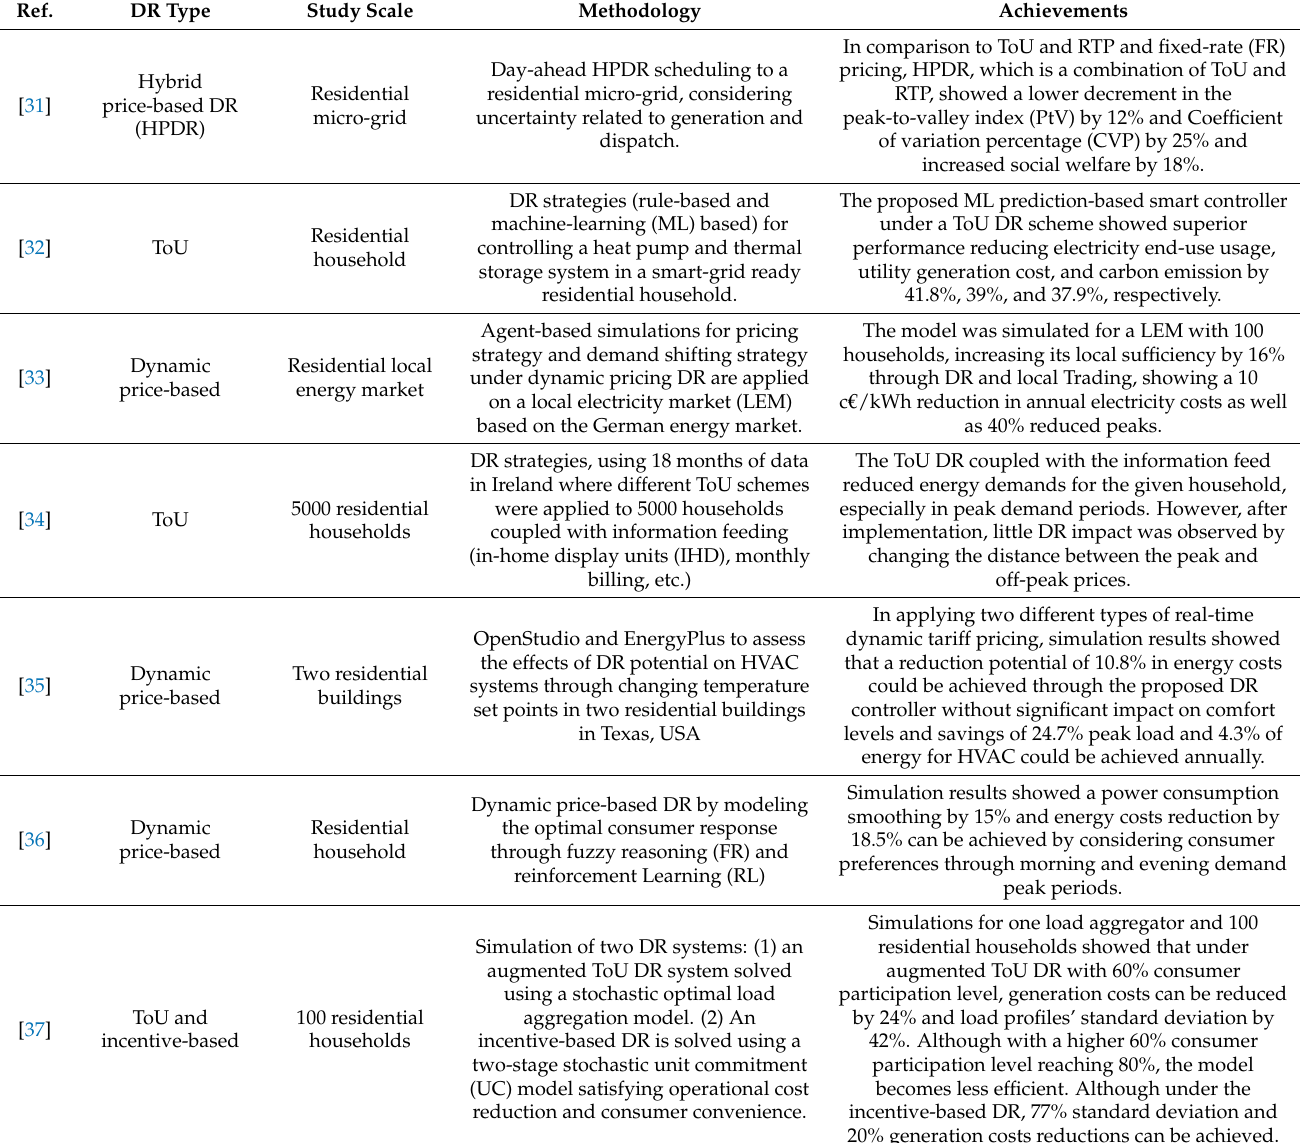
Table 1. Recent studies on Residential DR